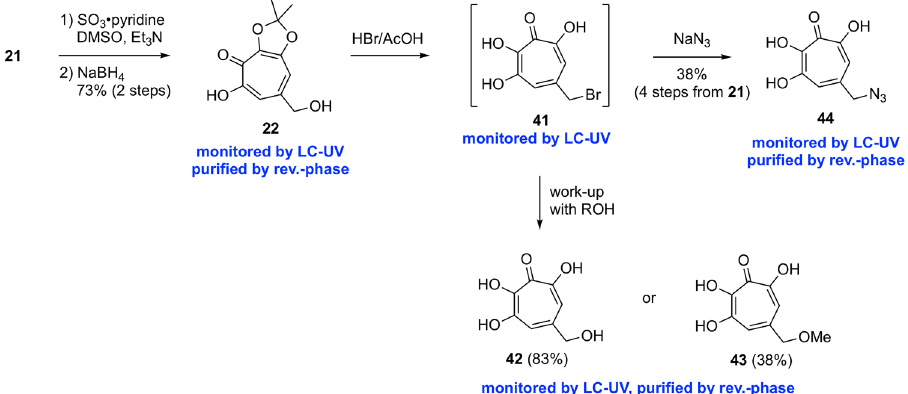
Figure 6. Synthesis of 6,7-dihydroxytropolones.